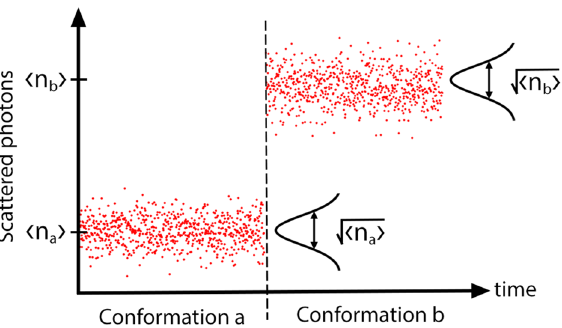
Figure 8. Illustration of the scattered photon flux that might be detected prior to, and after, a conformational change. Here, the random variation in the collected photon number within each period where the conformation is constant can be attributed to optical shot noise, while the discrete jump in the mean scattered photon number can be attributed to the change in polarizability due to the conformational change. Here mean scattered photon flux over the measurement time in conformations a and b , respectively. The difference between mean scattered photon number from states a and b must be greater than the noise for the change to be